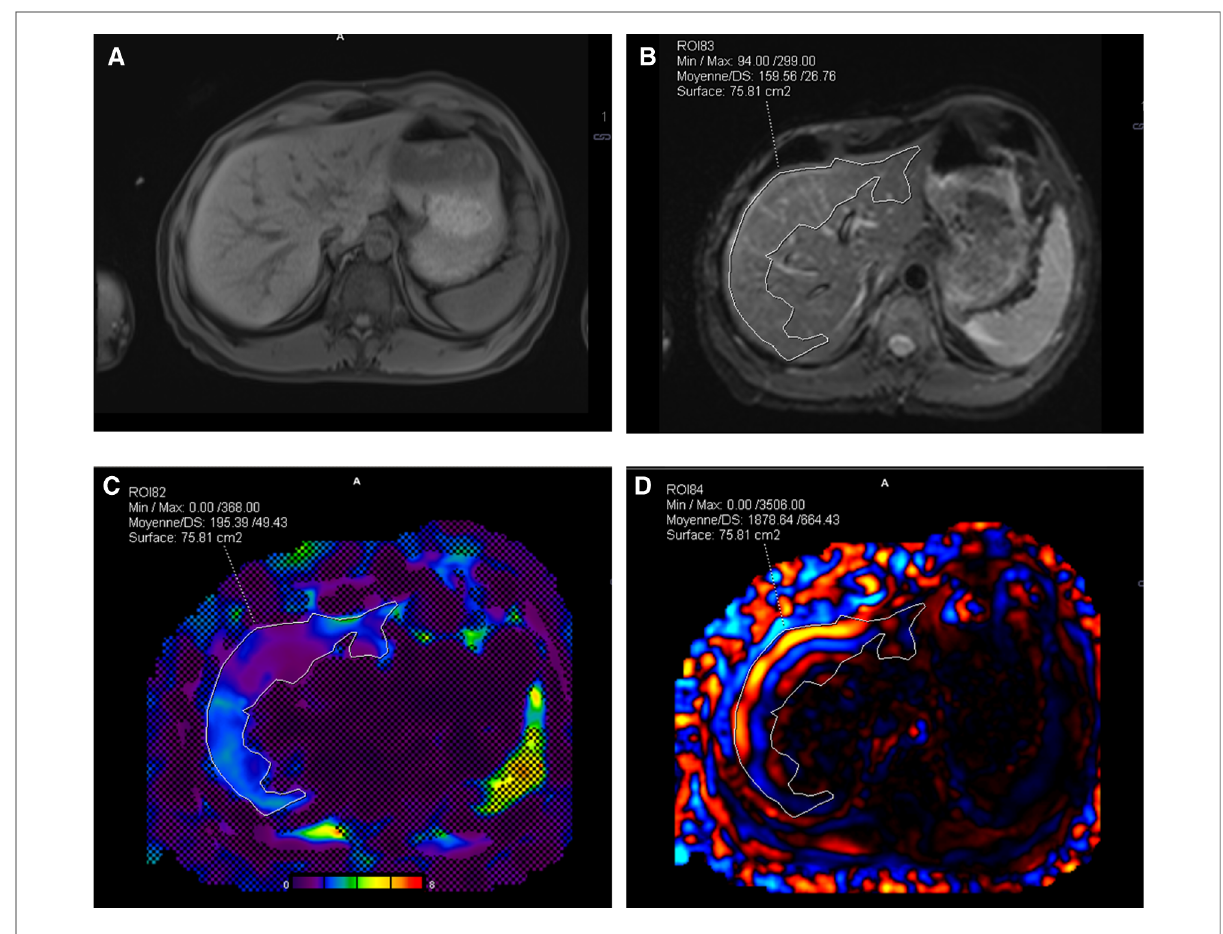
FIGURE 3 Illustration of Syngo.via work fl ow for postprocessing. ( A ) 3D Dixon T1w anatomic image of the liver in transverse plane acquired before MRE, ( B ) nearest anatomical MRE plane superimposed with the rROI, and ( C ) image fusion between stiffness map, 95% CI map, and rROI. ( D ) rROI overlapped on one shear wave instance. MRE, magnetic resonance elastography; CI, con fi dence interval; rROI, representative